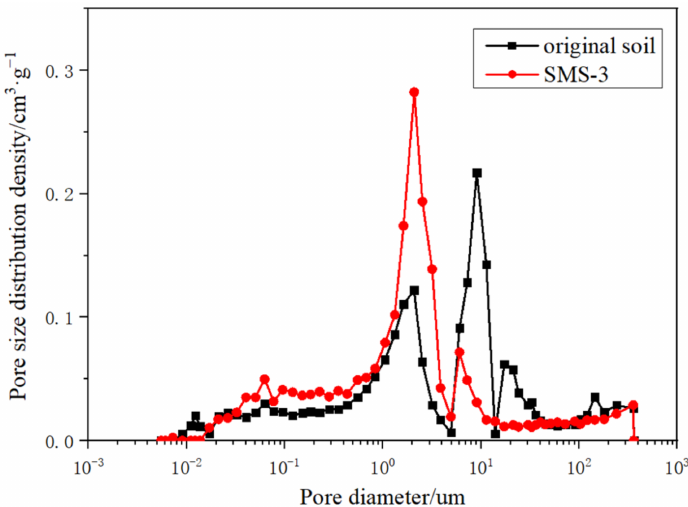
Figure 16. Mercury injection-mercury-ejection curve of soil